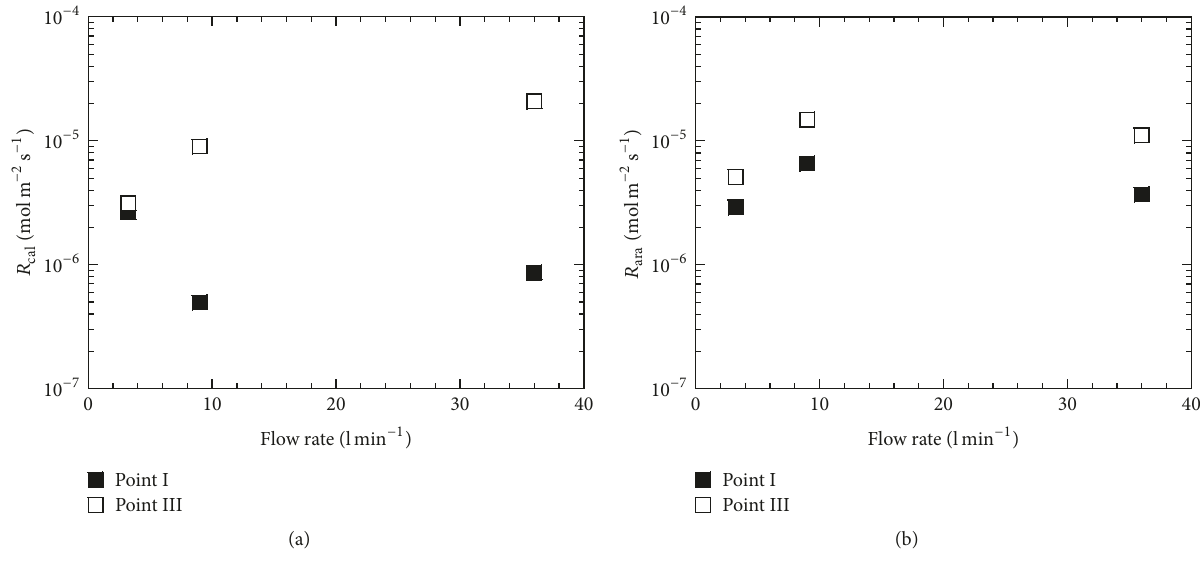
Figure 7: Flow rate dependence of R : (a) calcite and (b) aragonite.